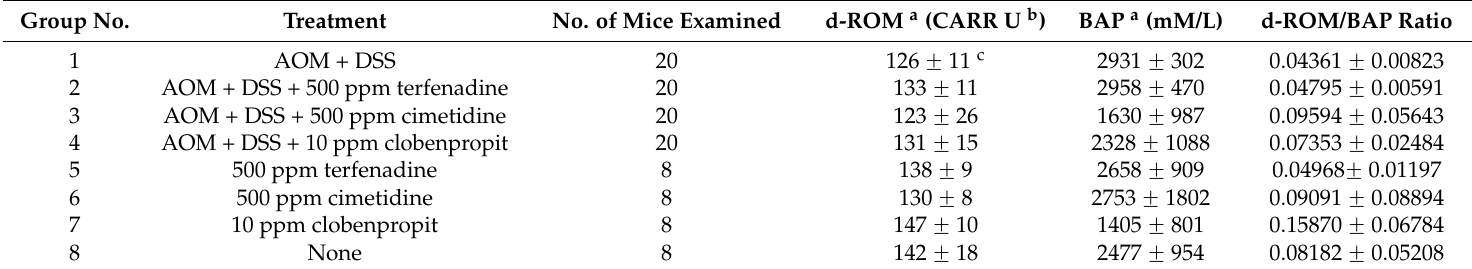
Table 2. Measurement of oxidative stress markers (18-week